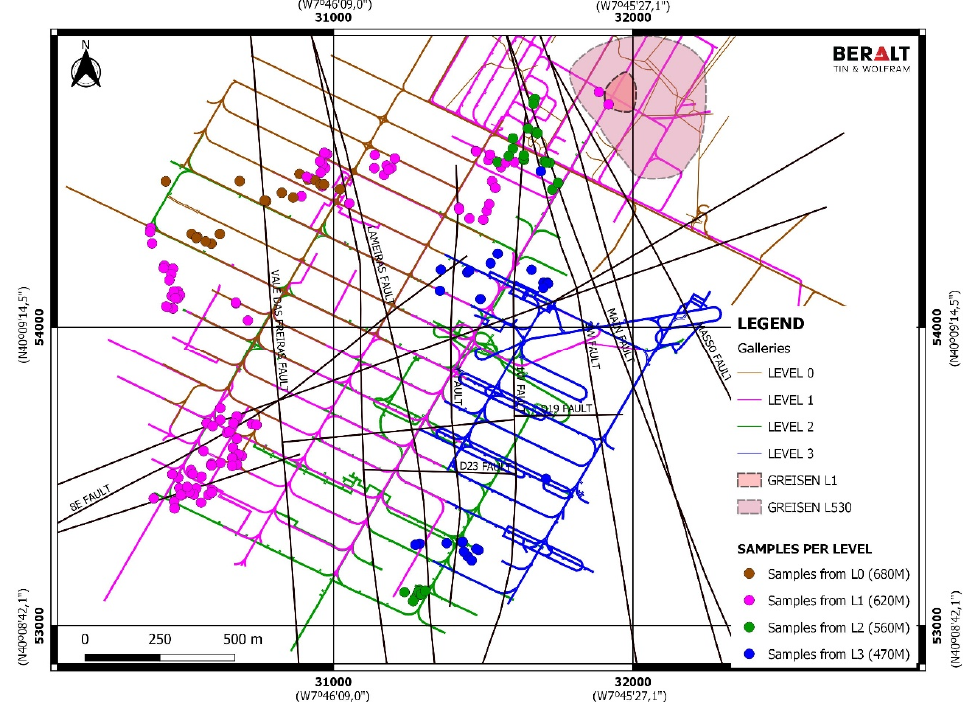
Figure 3. Sampling program in underground mining works carried out for the present study at the Barroca Grande sector placed to the south of Panasqueira and Vale Ermida sectors (indicated in the map by some old galleries). Heights L0, L1, L2, and L3 are altitudes in relation to the sea level.